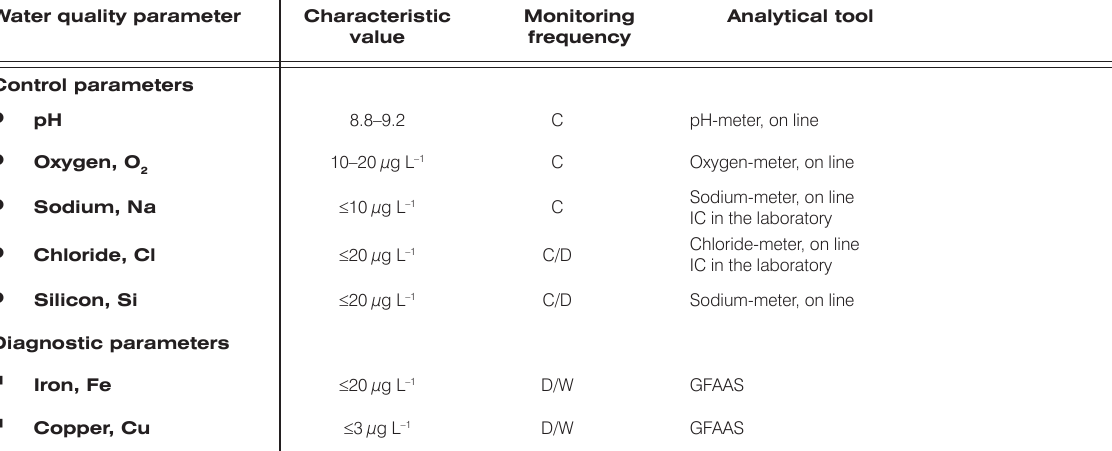
Table 2. Control and diagnostic water quality parameters, characteristic value and analytical methods within the WSC of the TPP Nikola Tesla [13 , 30